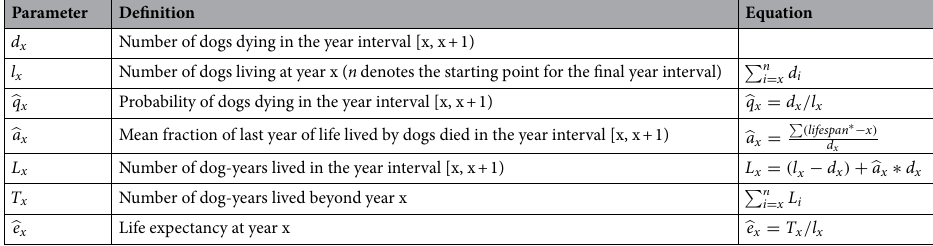
Table 1. Parameters used in a life table. *Lifespan of dogs dying in the year interval [x, x +